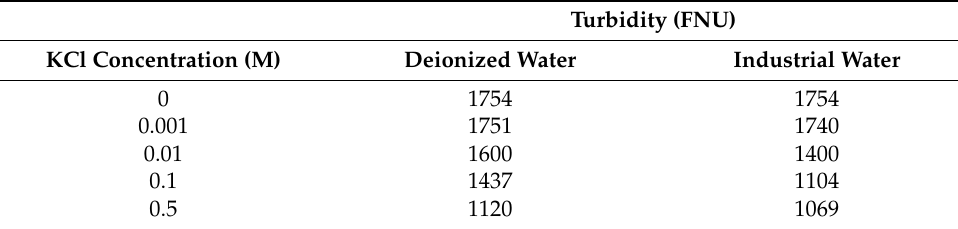
Table 8. Turbidity results used using KCl for each type of